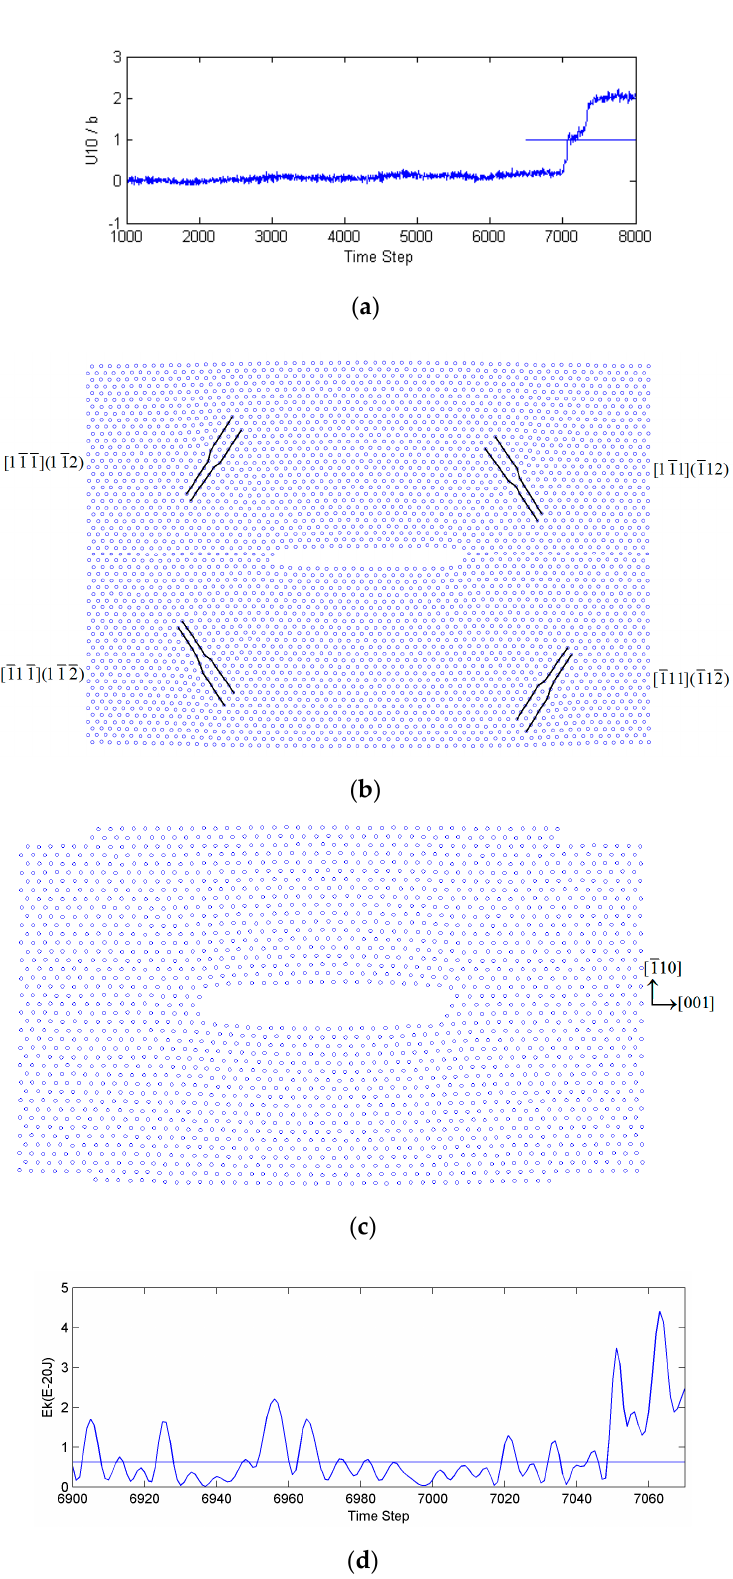
Figure 2. Temperature of 300 K, uniaxial tension (biaxiality ratio α = 0.0): ( a ) oscillating character of the relative shear displacements U10/ b in <111>{112} slip system at the crack tip; the short horizontal line indicates the threshold time t e at the first emission; ( b ) 2D visualization of the first dislocation emission at time step 7000 ( K A (t) = 0.688 MPa·m 1/2 , layer 19); ( c ) crack blunting after multiple emissions, time step 8000, layer 15; ( d ) local kinetic energy at the crack tip before and during the first dislocation emission; the last peak value shows the time t e = 7068 h of the dislocation emission from Figure 2a.